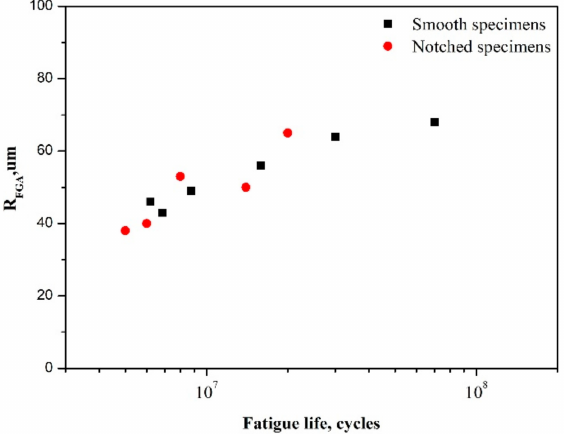
Figure 13. Relationship between the size of the FGA and the number of cycles to failure.